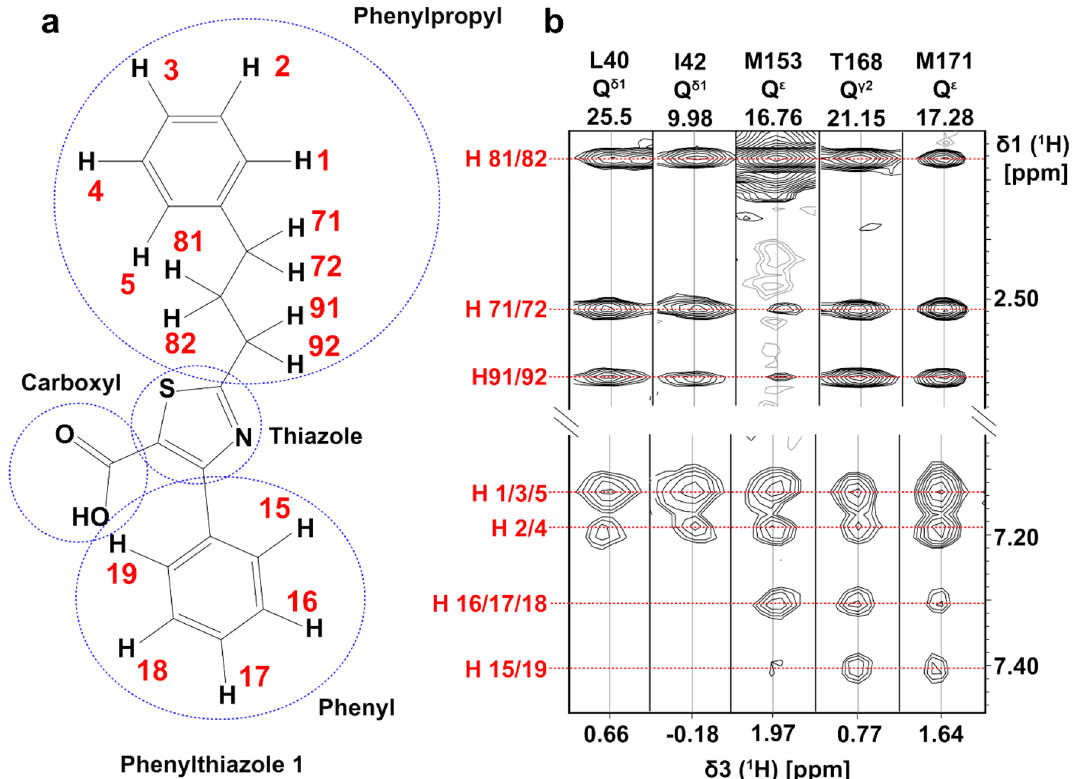
Figure 2. Intermolecular NOEs between oxidized EcDsbA and phenylthiazole 1 . ( a ) Chemical structure of phenylthiazole 1 . ( b ) [ 1 H, 1 H] strips from 3D 13 C-edited [ 1 H, 1 H]-NOESY HMQC spectrum of 0.25 mM Ec DsbA with 3.5 mM phenylthiazole 1 recorded at 298 K with an NOE mixing time of 400